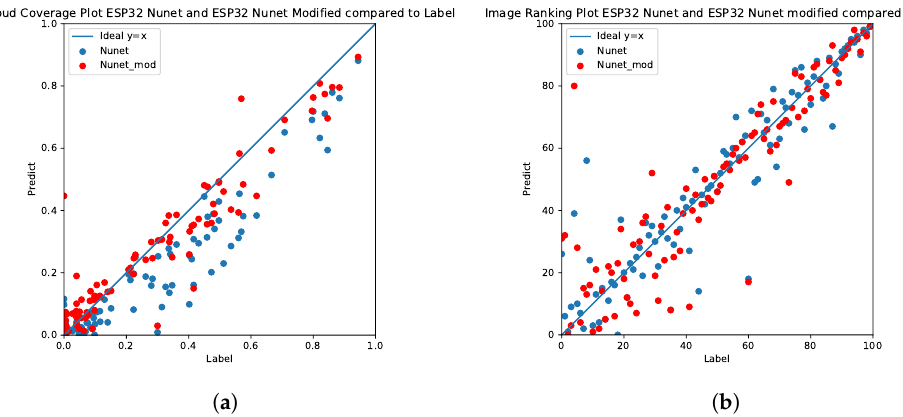
Figure 8. Comparison of predicted output by NU-Net and NU-Net-mod against the expected result of image labels on embedded device ESP32. ( a ) Cloud coverage; ( b )